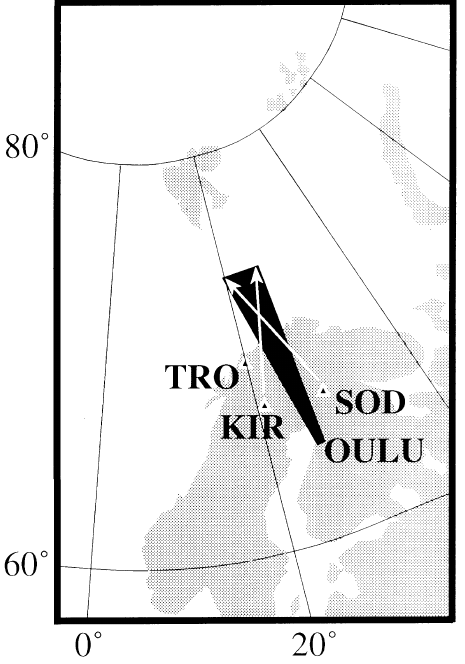
Fig. 1. A map illustrating the experimental geometry for the Barker and FAST-COSC experiments. The grid corresponds to geographic